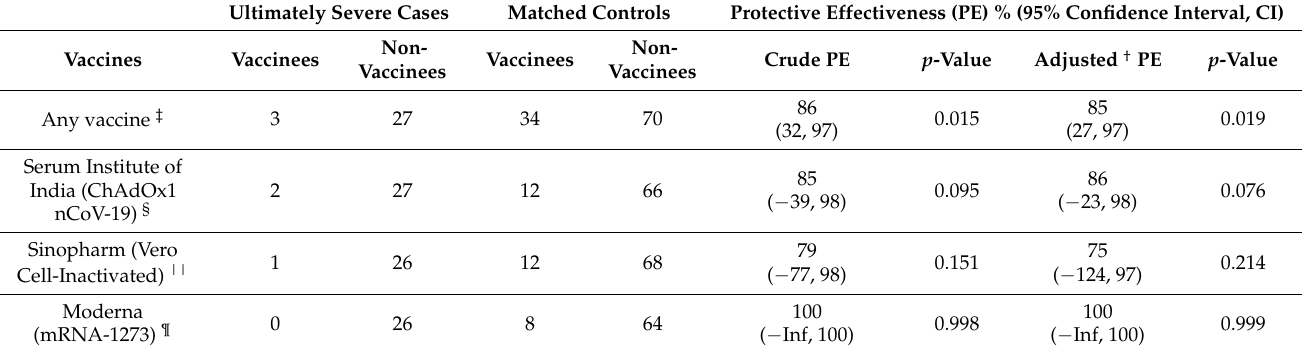
Table 3. Protection against ultimate severe COVID-19 disease by the receipt of complete regimens of vaccines *.